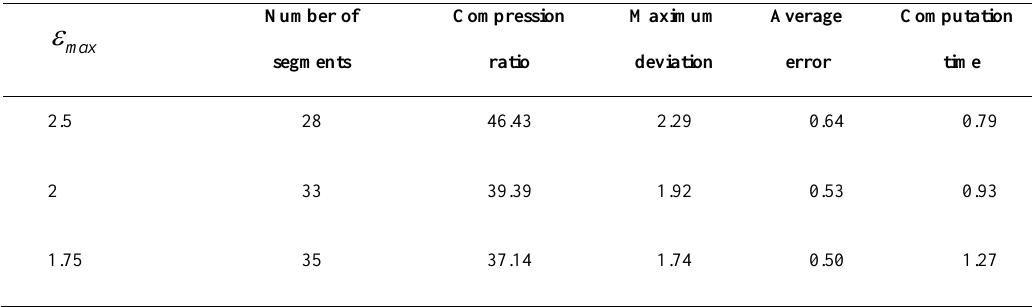
Table 1. Performance of the proposed algorithm for the shape of the Arabic word "Sabr".